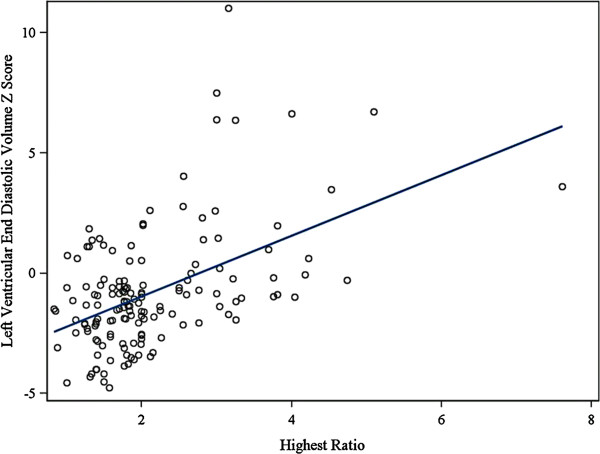
LVED Z-score vs NC/C ratio. There is a linear relationship with r = 0.40 (p < 0.0001). As the LVED increases the NC/C ratio also increases. DMD, Duchenne Muscular Dystrophy; LVEDV, left ventricular end diastolic volume; NC, noncompacted length; C, compacted length.